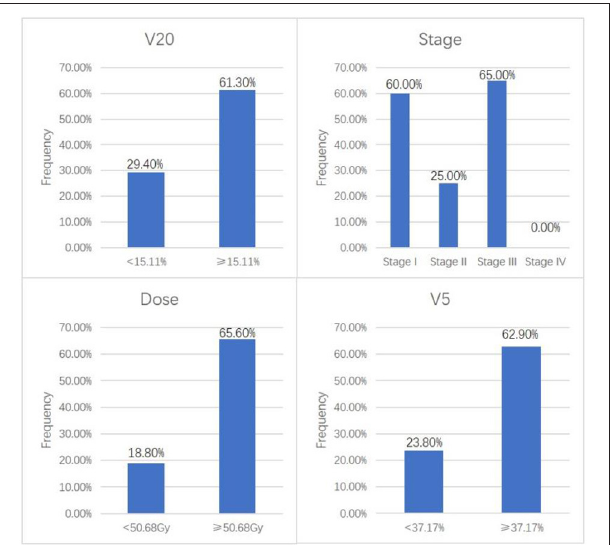
FIGURE 2 | Univariate analysis showing the incidence of RP with statistically significant factors.